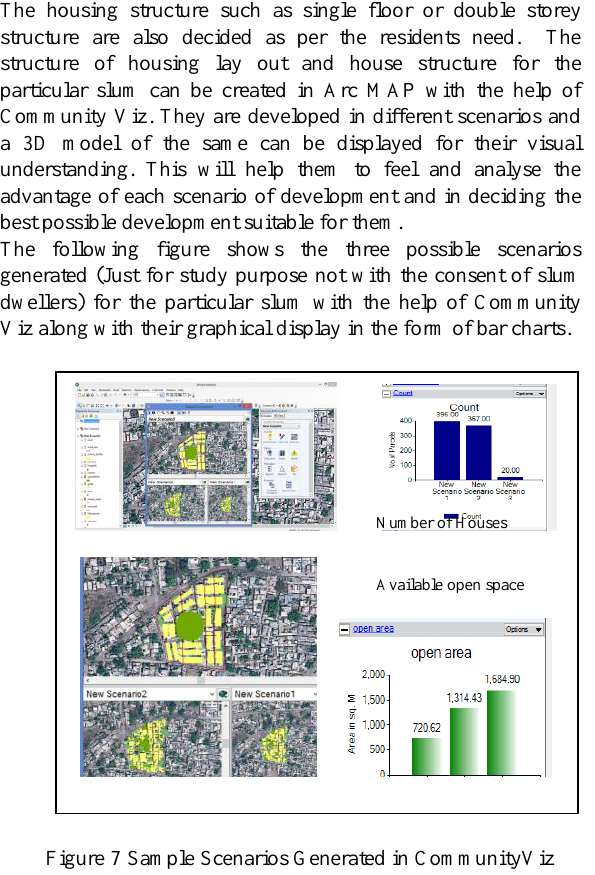
Figure 7 Sample Scenarios Generated in CommunityViz